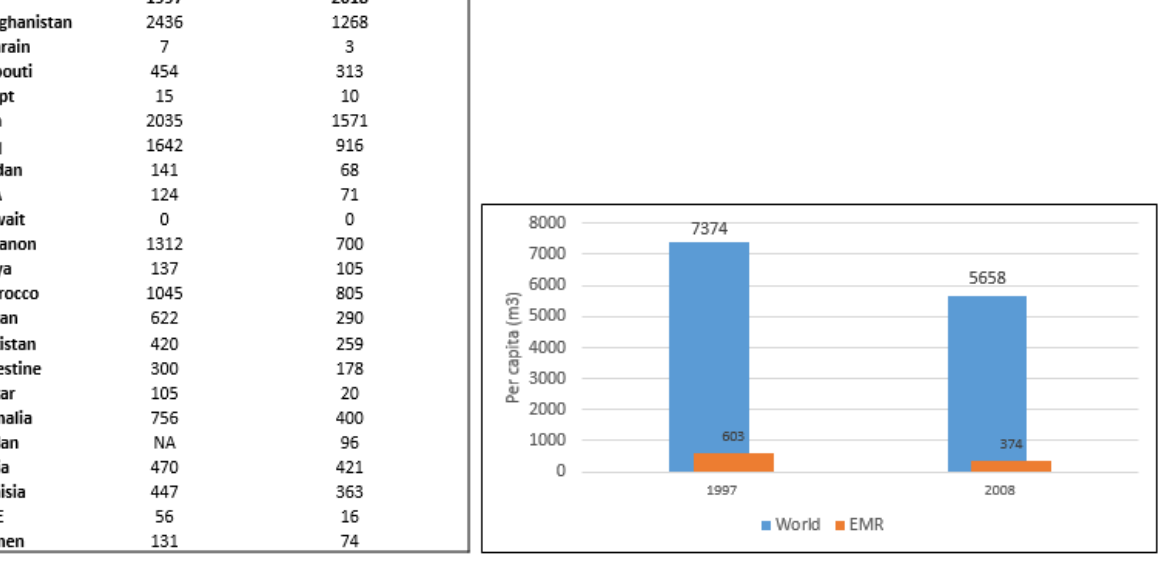
Figure 4. Per capita levels of renewable internal freshwater resources (m 3 ) in countries of the EMR and change in these levels in the world vs. in the EMR. Abbreviations: EMR: Eastern Mediterranean Region; KSA: Kingdom of Saudi Arabia; UAE: United Arab Emirates.